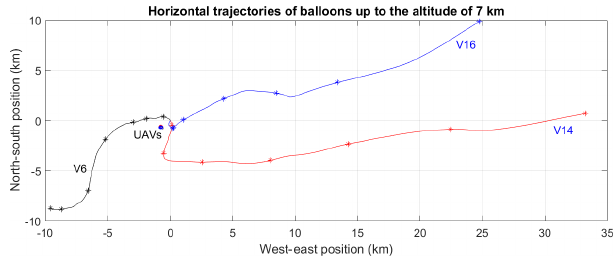
Figure 1. Horizontal trajectories of the meteorological balloons V6, V14 and V16. Each asterisk shows altitudes of 1km, 2km, etc., up to 7km. The position (0, 0) corresponds to the location of the Shi- garaki MU Observatory. The circular patterns of the UAV trajecto- ries are also